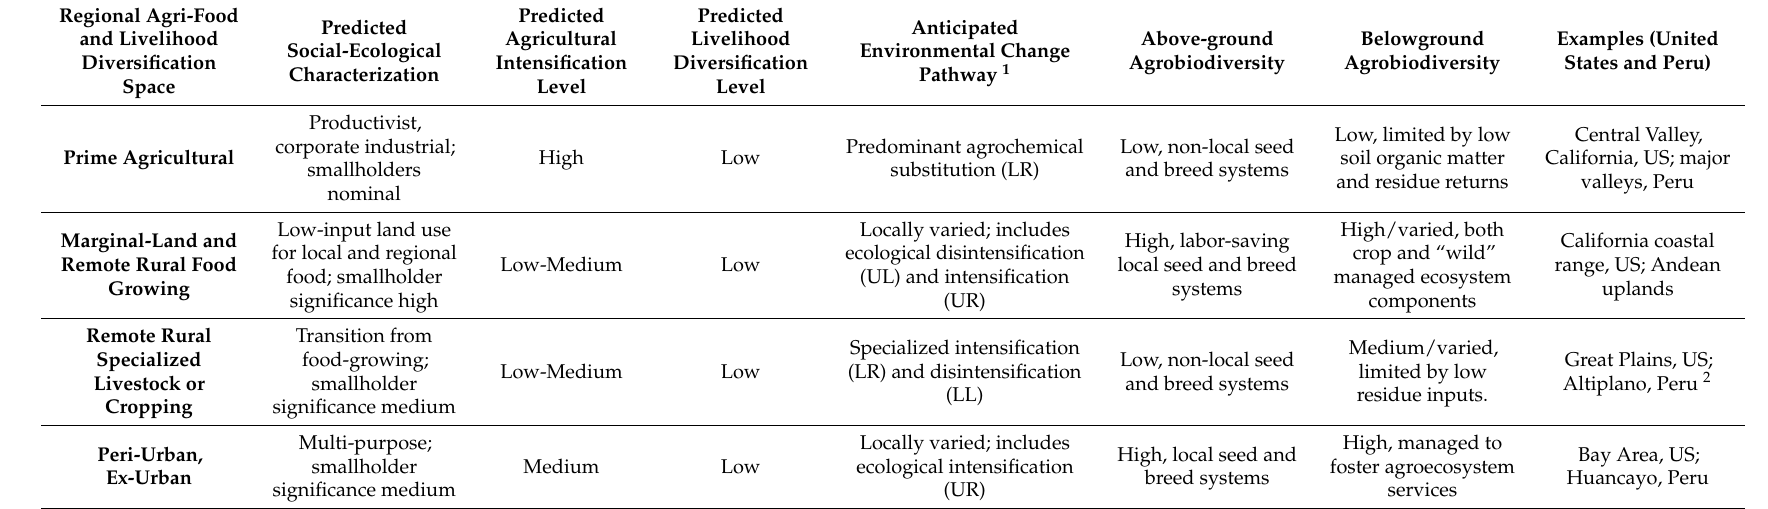
Table 5. Predicted spatial-geographic patterning and the predominant processes of agrobiodiversity and Regional Agri-Food and Livelihood Diversification Spaces (RALDS is discussed in Section 5. Impacts in this table refer to both above- and belowground agrobiodiversity per Section